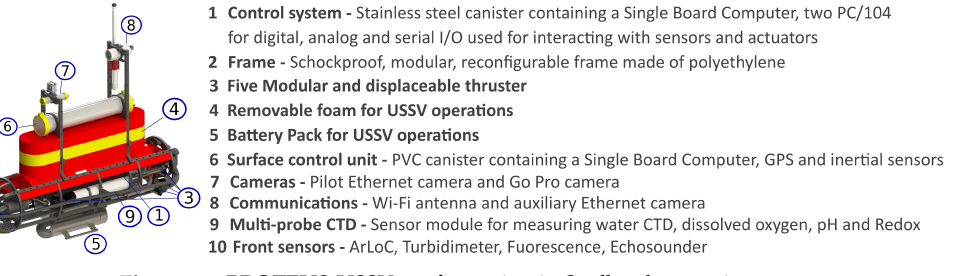
Figure 10. PROTEUS-USSV configuration in Svalbard